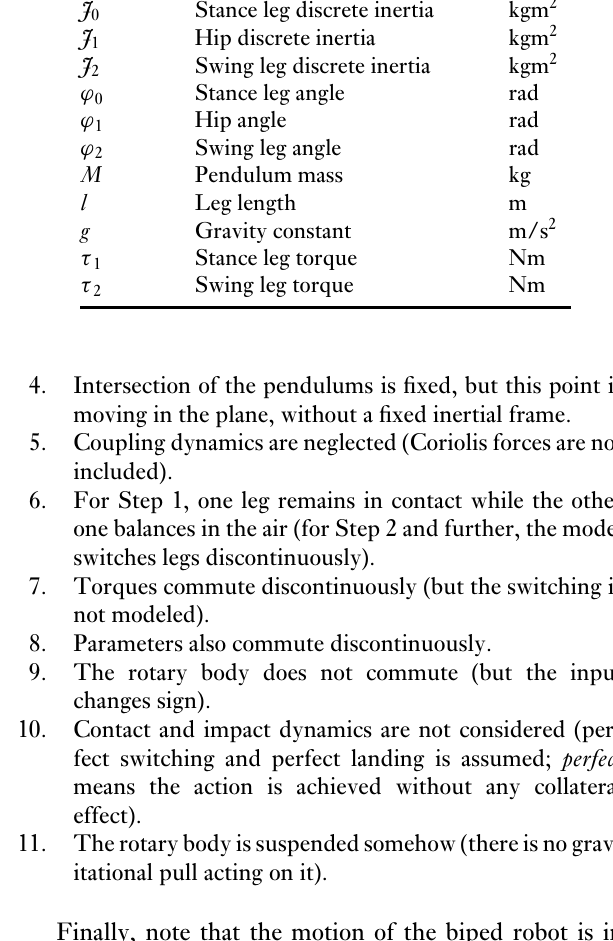
Table 1 Description of the parameters Symbol